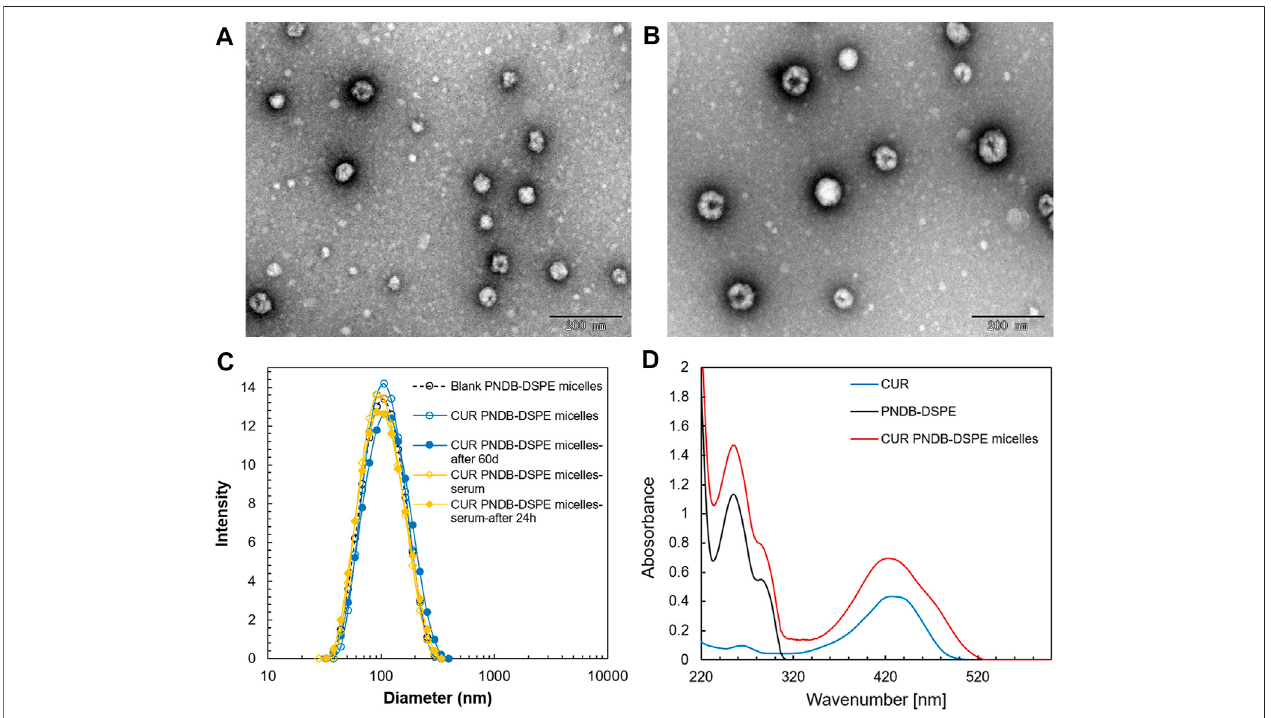
FIGURE 4 | TEM images of blank PNDB-DSPE micelles (A) and CUR-PNDB-DSPE micelles (B) . Hydrodynamic size distributions of blank PNDB-DSPE micelles and CUR-PNDB-DSPE micelles (C) . The UV – Vis analysis of free CUR, blank PNDB-DSPE micelles, and CUR-PNDB-DSPE micelles (D)